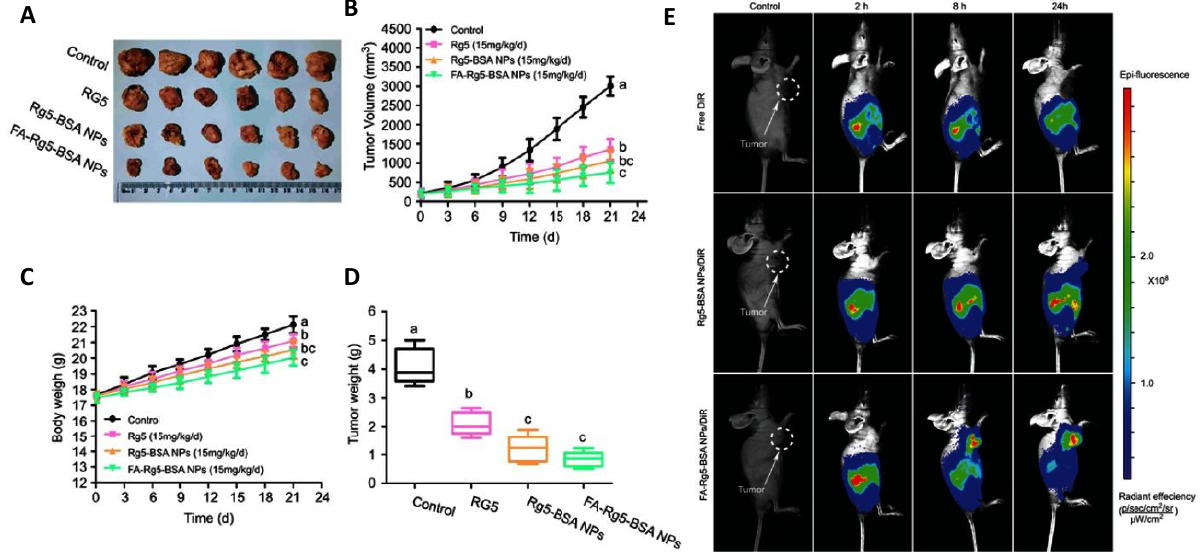
Figure 4. Ginsenoside-fabricated BSA NPs exhibited significant inhibition of breast cancer xenografts ( A ) tumor size, ( B ) tumor volume, ( C ) body weight, ( D ) tumor weight, and ( E ) in vivo bioluminescence after treatment for 21 days. Different letters (a,b,c) indicate significant differences between each group. Adapted with permission from [44] under (CC BY-NC 3.0).